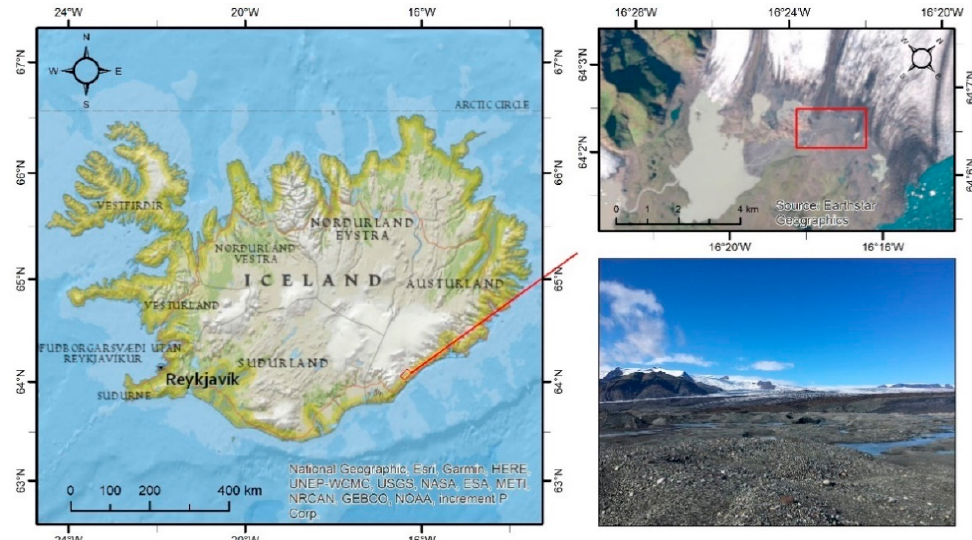
Figure 1. Location of the study area and a photo from the study area where the flight took place. The study areas represent a typical proglacial landscape, built from sands and gravel.